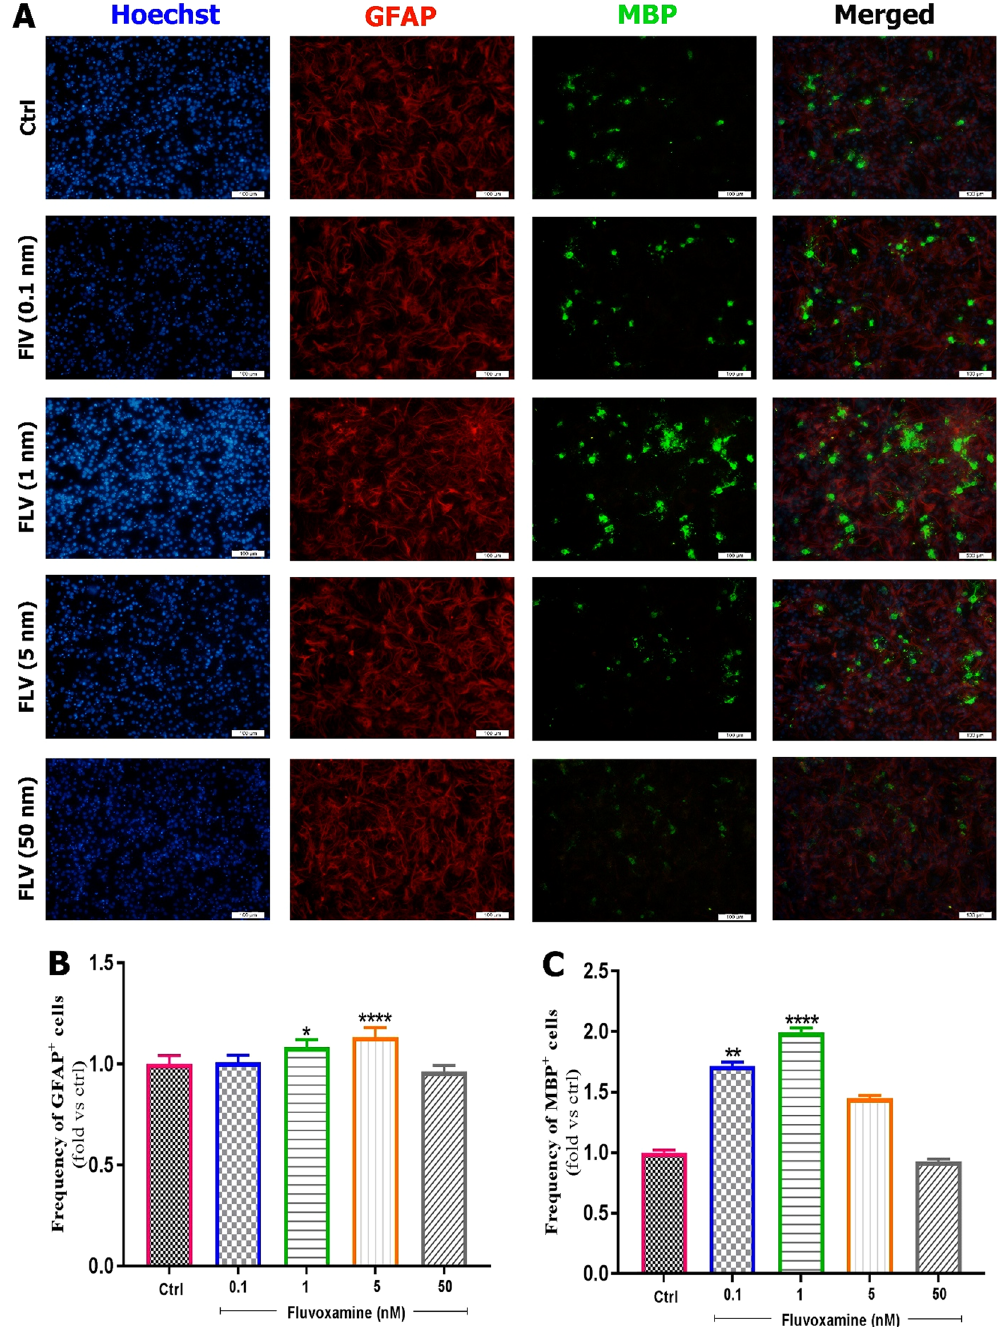
Figure 4. Effect of fluvoxamine on eNSC differentiation to glial and oligodendrocyte cells. ( A ) Representative immunofluorescence images of differentiated embryonic NSCs stained with GFAP (Glial Fibrillary Acidic Protein, an astrocyte marker, red) or MBP (Myelin Basic Protein, an oligodendrocyte marker, green) and Hoechst (a nuclei marker, blue) in control, and treated groups at day 6. White scale bars indicate 100 &#x1D707;m. ( B , C ) Quantification of the frequency of GFAP and MBP positive cells in treated groups, normalized to the control group. Results showed that fluvoxamine at 1 and 5 nM concentrations are optimal for differentiation to MBP and GFAP positive cell, respectively. Each group included 3 replicates (n = 3). Values are presented as mean ± SEM for 15 field/well. Statistical analyses were performed by one-way analysis of variance followed by Tukey test. * p < 0.05; ** p < 0.01; *** p < 0.001 and **** p <